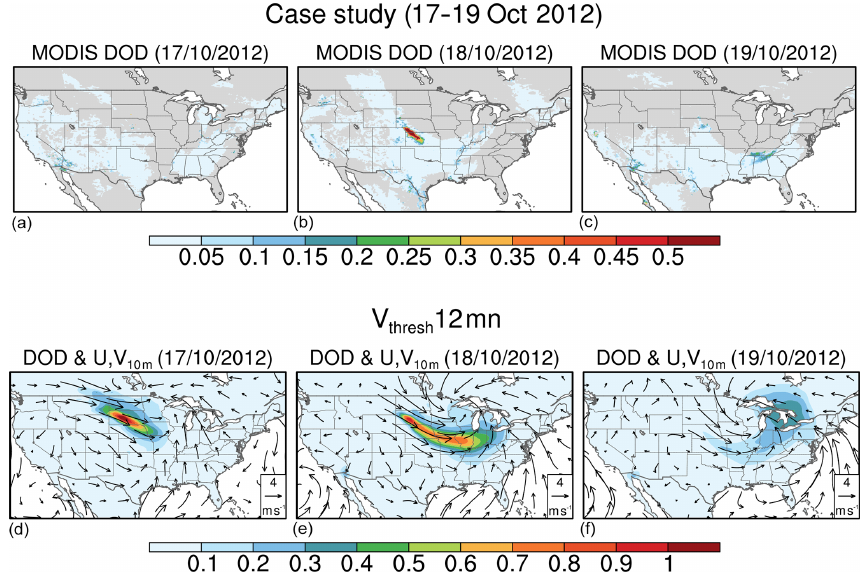
Figure 14. (a–c) Daily DOD from MODIS. (d–f) Daily DOD simulated by the V thresh 12mn run along with anomalies (with reference to the 2000–2015 mean) of surface wind vectors (ms − 1 ) from 17 October to 19 October 2012. Only DOD over land is shown. Missing values in MODIS DOD (a–c) are plotted in grey